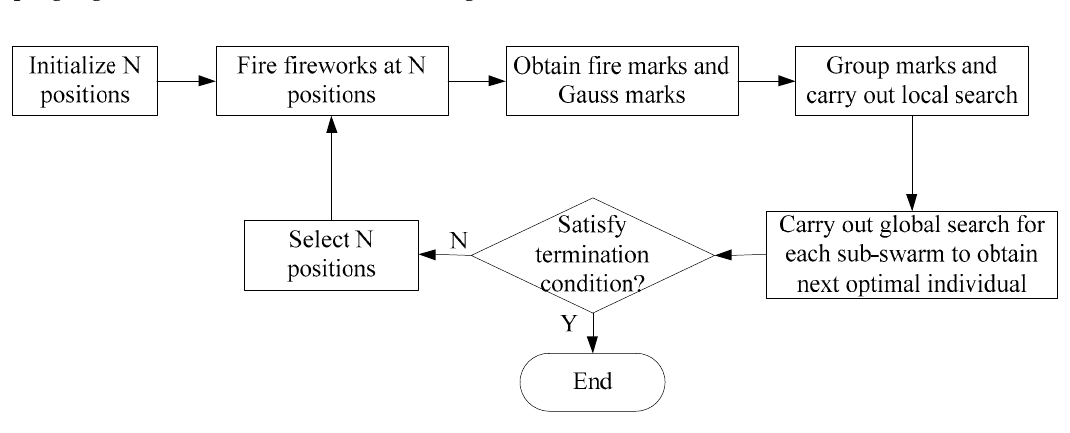
Figure 4. Flowchart of FA-SFLA algorithm.